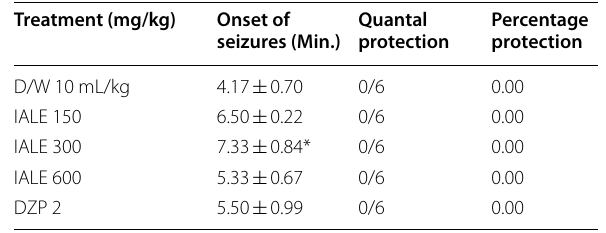
Data are presented as Mean to D/W group—One-way ANOVA followed by Dunnett’s post hoc test, n D/W Distilled water, IALE =